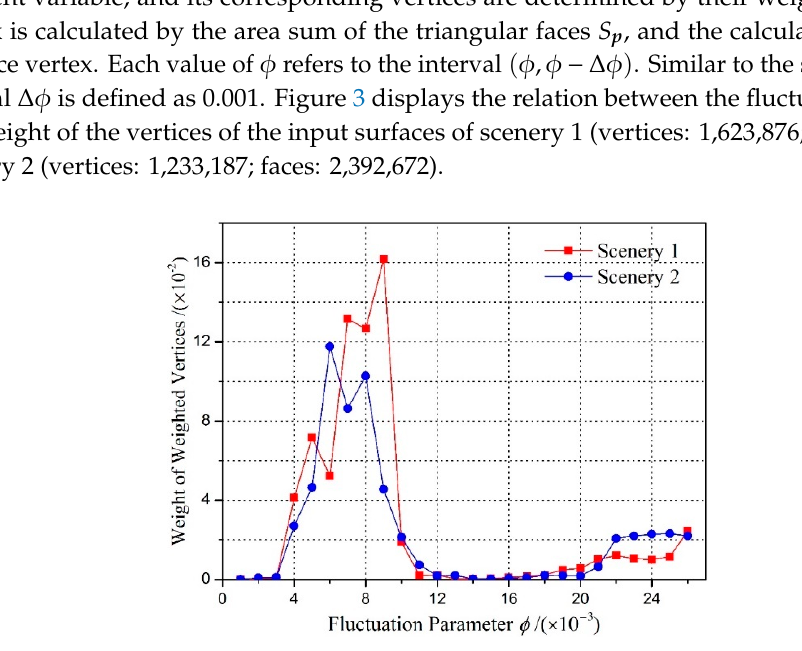
Figure 3. Two intervals with values of approximately zero appear. The first is located at the start, indicating that an entirely planar surface does exist. The interval between the two quasi-zero intervals represents a planar surface. Therefore, ε φ is located in the second quasi-zero